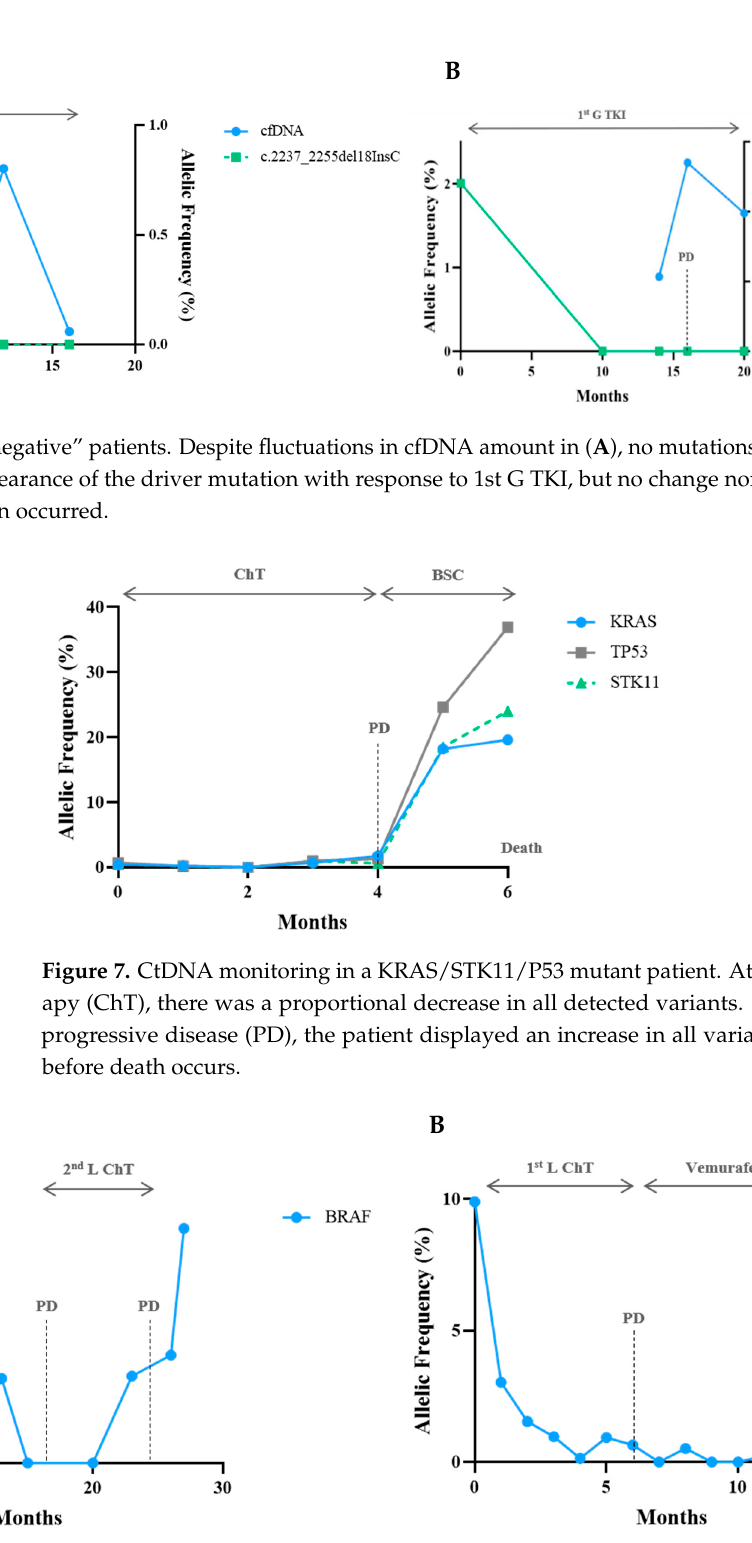
Figure 5. Complete ctDNA monitoring of a patient with Del19 EGFR mutation and representative CT scans at indicated time points. With both 1st and 3rd G TKIs, clinical response was accompanied by molecular decrease in the driver muta- tion. Clinical progression was preceded by an increase in del19 and the appearance of the T790M. After the initiation of the 3rd G TKI, partial response was observed with ctDNA clearance of both clones. At the recurrence time, the patient lost the T790M, del19 reappeared, and the C767S in cis was detected. Plasmatic alterations at progression were both confirmed with a tissue biopsy represented by *. Red circles refer to main tumour lesions.